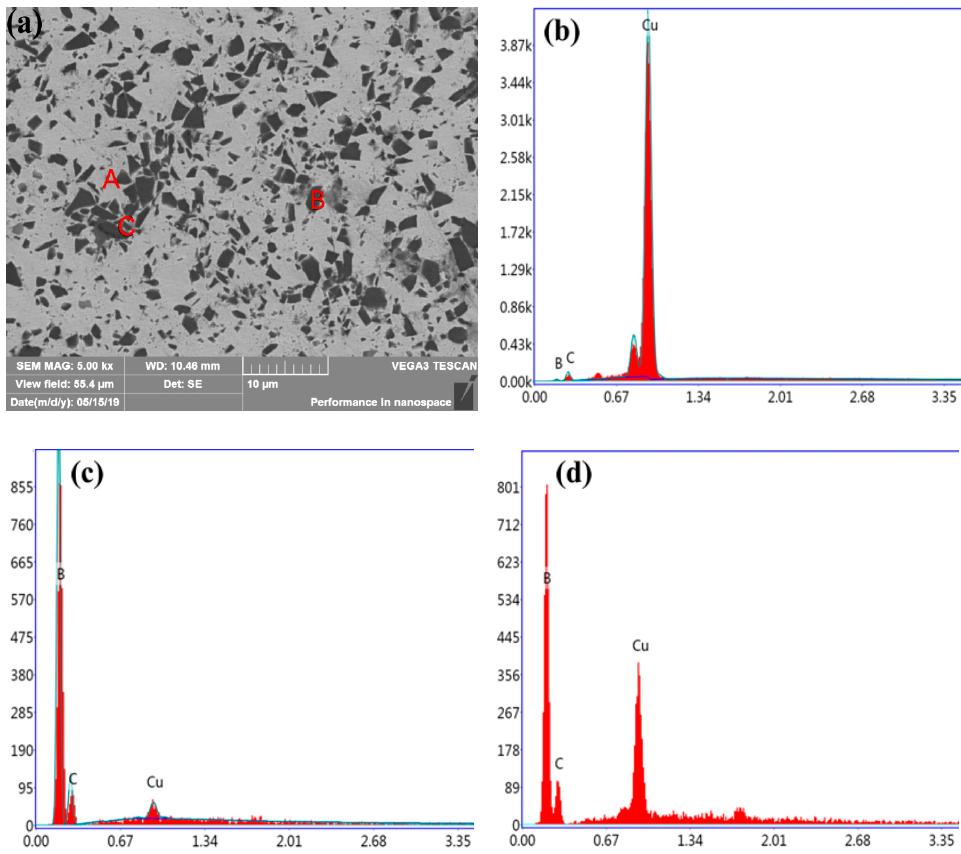
Figure 5. The EDS analysis results of Cu-10 wt.%B 4 C composite: ( a ) the microstructure of Cu-10 wt.%B 4 C composite; ( b ) EDS analysis of point A; ( c ) EDS analysis of point B; ( d ) EDS analysis of point C.